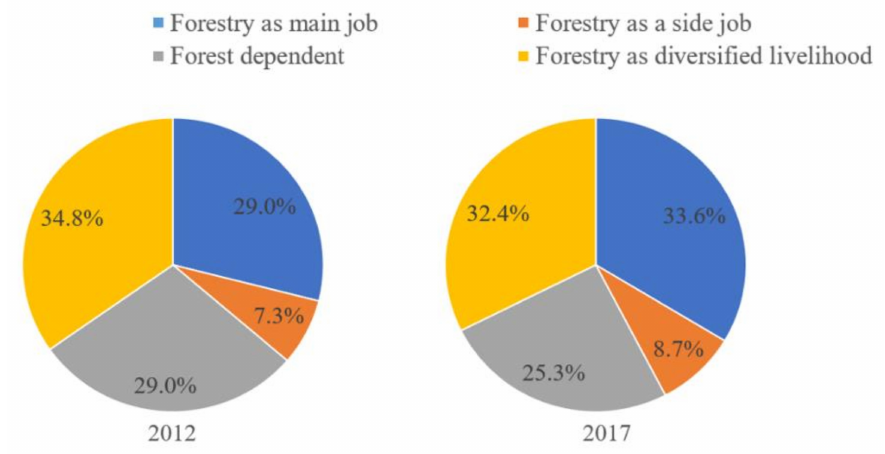
Figure 2. Change in livelihood strategies of worker households. Table 4. Change in welfare functions of livelihood types before and after logging